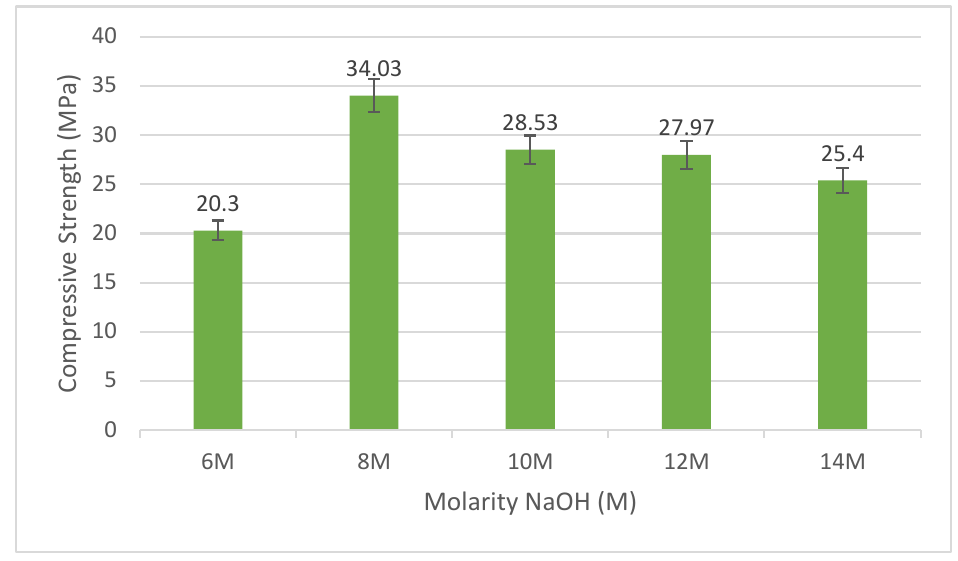
Figure 1. Fly ash/dolomite geopolymer compressive strength. The 8 M of NaOH centered on fly ash/dolomite-based geopolymer demonstrates op- timum intensity, due to the improved shape, reaction and efficient geopolymer formula- tion between the dolomite and alkaline activator. This is because 8 M NaOH molarity could provide enough ions of Na and OH to react with the fly ash and dolomite to release Al 3+ and Si 4+ ions. The optimum NaOH concentration contains adequate Na + ions content which makes the fly ash and dolomite composition uniform, thus improving the geopol- ymerization rate by balancing charges as well as forming an aluminosilicate network. This is proved by Khale and Chaudhary [14] that found the accurate rate of NaOH concentra- tion will form great dissolution of silica and alumina from the raw materials thus directing to improved strength. Figure 2 shows the illustration of the ion balance and dissolution process in the dolomite/fly ash based geopolymer. The Na + ions were needed for the dis- solution of the geopolymer material to release Al 3+ and Si 4+ ions, meanwhile the OH − ions will react with the released ion during the geopolymerization process. Kiatsuda Somna et al. studied the stand-alone fly ash geopolymer with 4.5 – 16.5 M NaOH used. With focus on strength, the compressive strengths at 28 days of 20.0 – 23.0 MPa were obtained with NaOH concentrations of 9.5 – 14.0 M. Increasing the NaOH concentration beyond this Figure 2. Ion balance and dissolution process in the dolomite/fly ash based geopolymer. point resulted in a decrease in the strength of the paste due to the early precipitation of aluminosilicate products [15]. This shows the same pattern as the finding in this experi- However, with NaOH concentrations of 10 M to 14 M, the fly ash/dolomite com- ment. pressor capacity becomes slow. This was due to the excess of Na + and OH − ions from the high molarity of NaOH used. The unnecessary OH − ions in the geopolymer